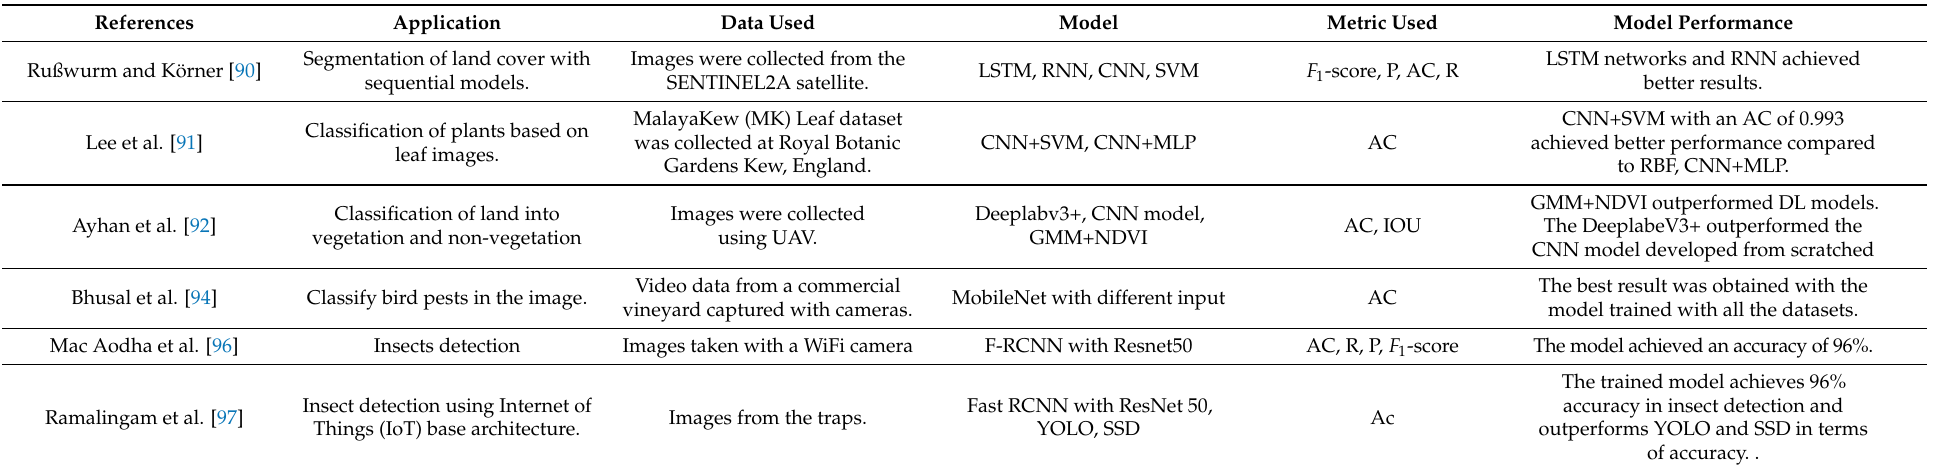
Table 6. Feature descriptions of recent published papers in the field of “Species